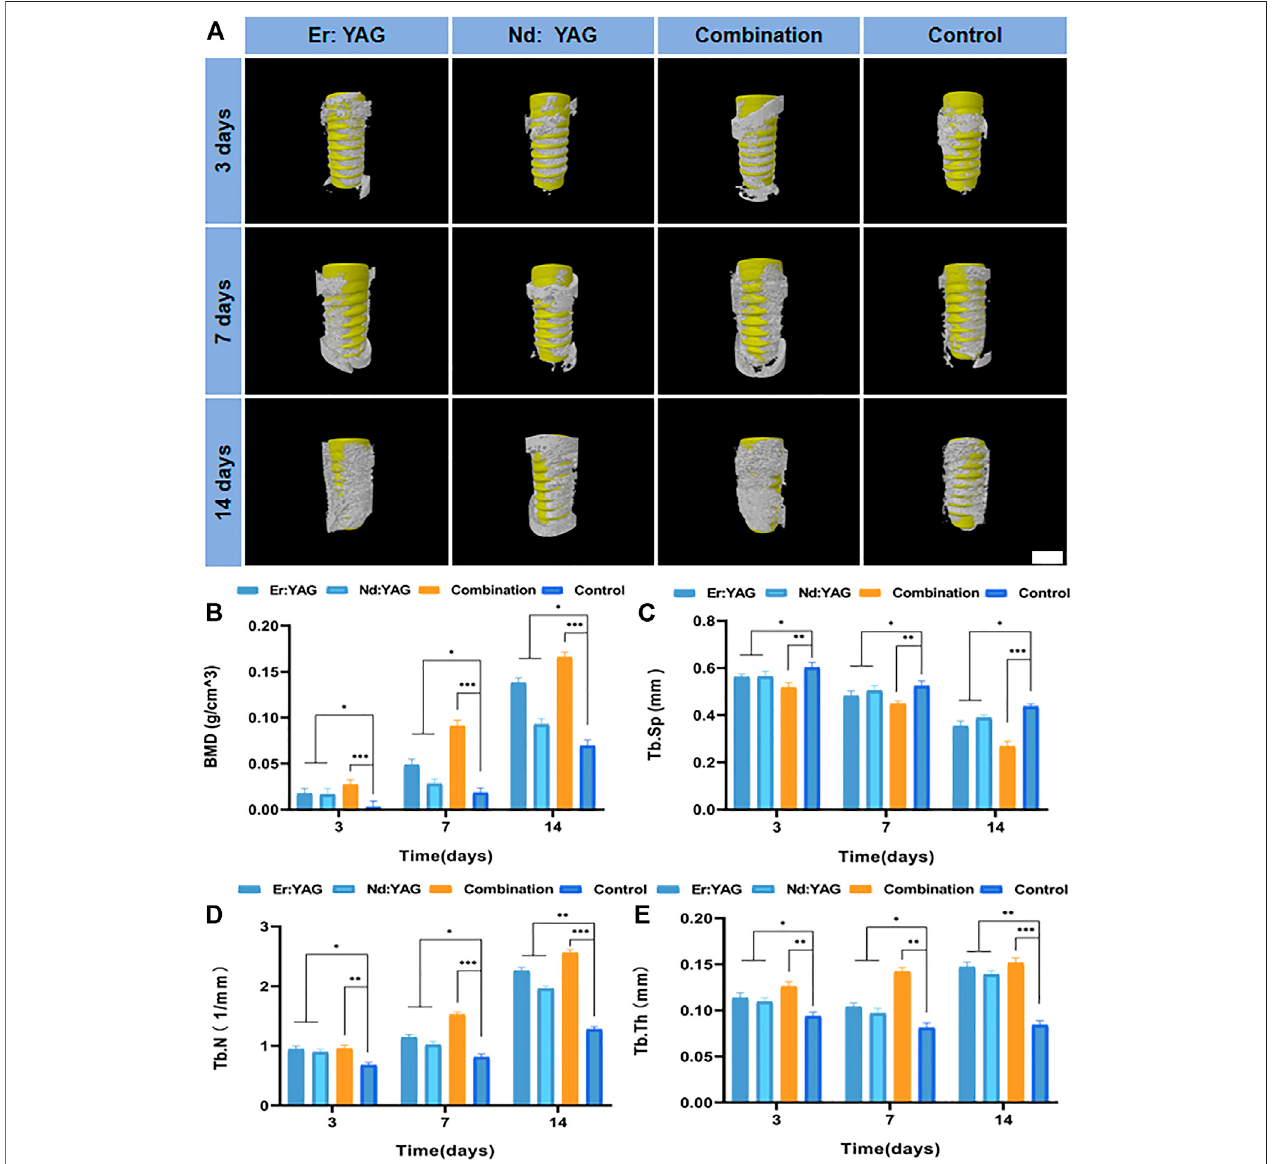
FIGURE1| Micro-CTanalysisofboneintegration. (A) Representative3Dreconstructed micro-CTimagesaroundtheimplant(scalebar=4 mm)andthe (B) BMD, (C) Tb. Sp, (D) Tb. N, and (E) Tb. Th of each group after 3, 7, and 14 days of implantation ( n = 3, *indicates signi fi cant differences between the groups, * p < 0.05; ** p < 0.01; *** p <